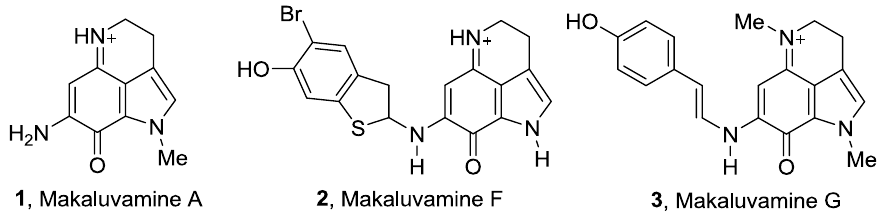
Figure 1. A few examples of naturally occurring